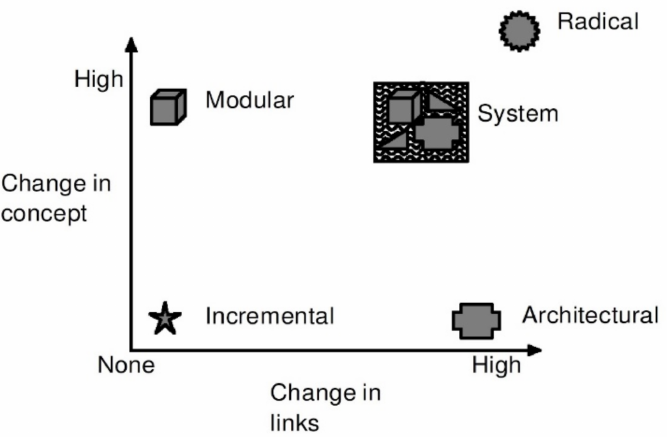
Figure 14. Categories of innovations by changes in concept and links to other systems. Reprinted with permission from ref. [54]. Copyright 2000 Taylor &